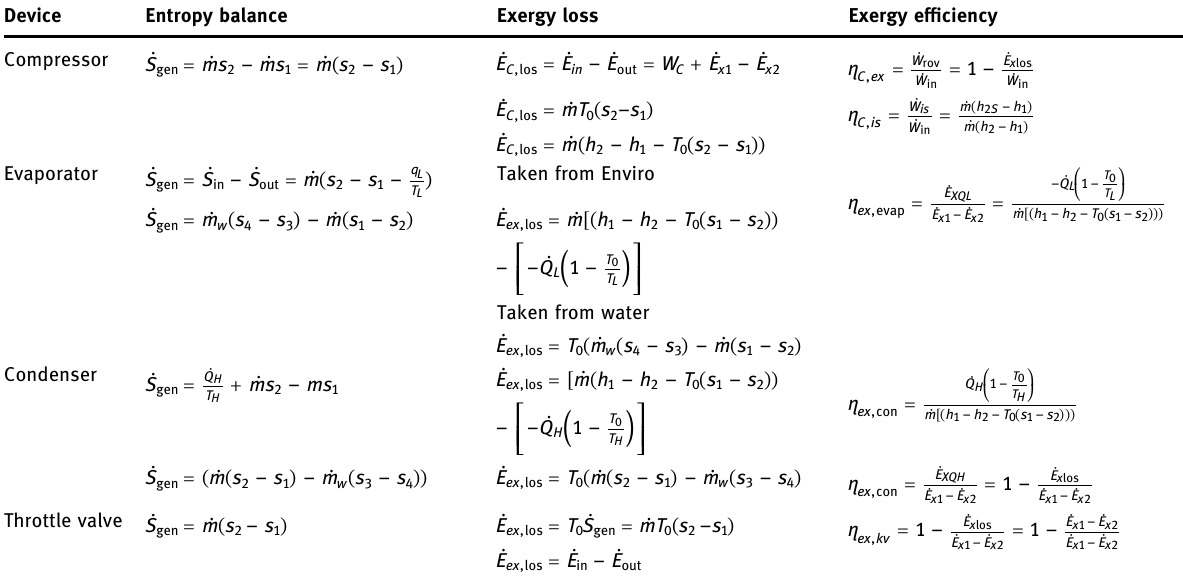
Table 5: General formulas of entropy balance, exergy loss, and exergy e ffi ciency of the devices of the three - stage vapor compression cascade cryogenic cycle [ 2,4 – 6 ]